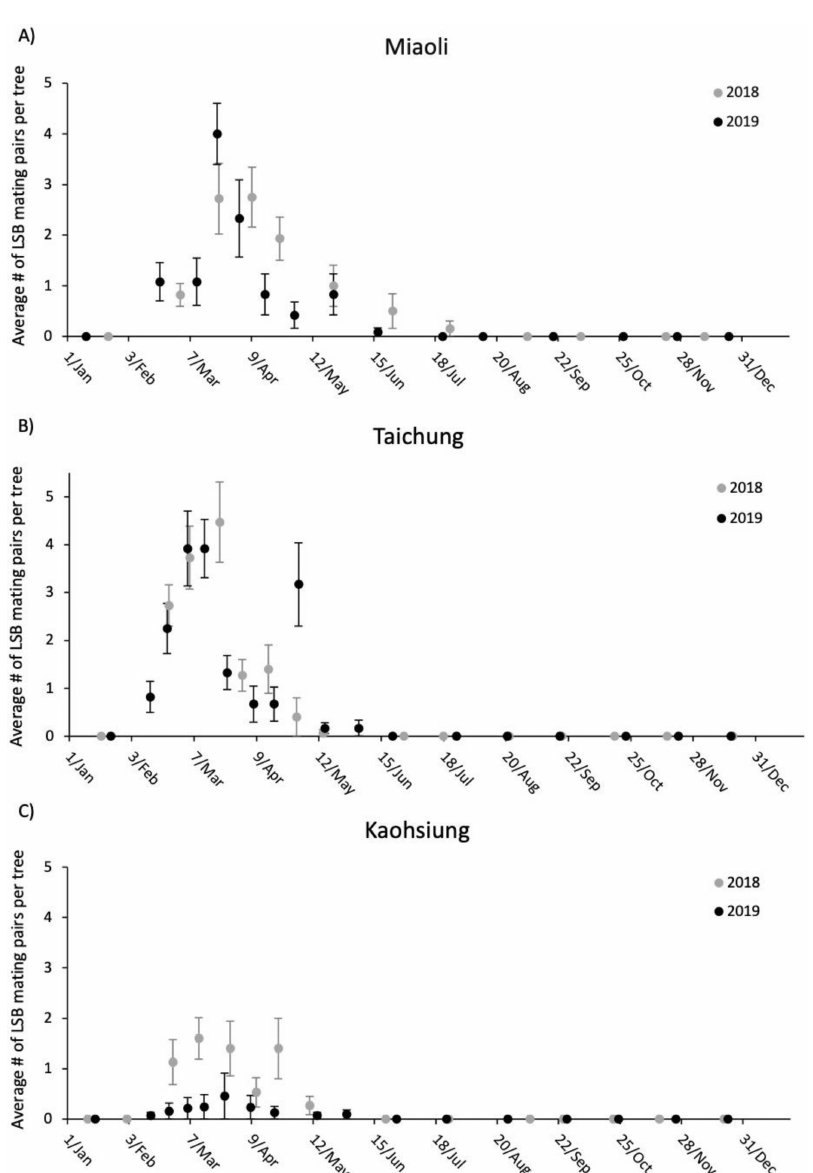
Figure 3. Dot plots with standard error bars of average number of observed LSB mating pairs per tree from January through December at Miaoli ( A ), Taichung ( B ), and Kaohsiung ( C ) for 2018 (grey) and 2019